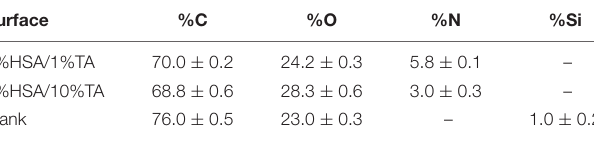
TABLE 1 | XPS elemental composition of treated and untreated scaffold